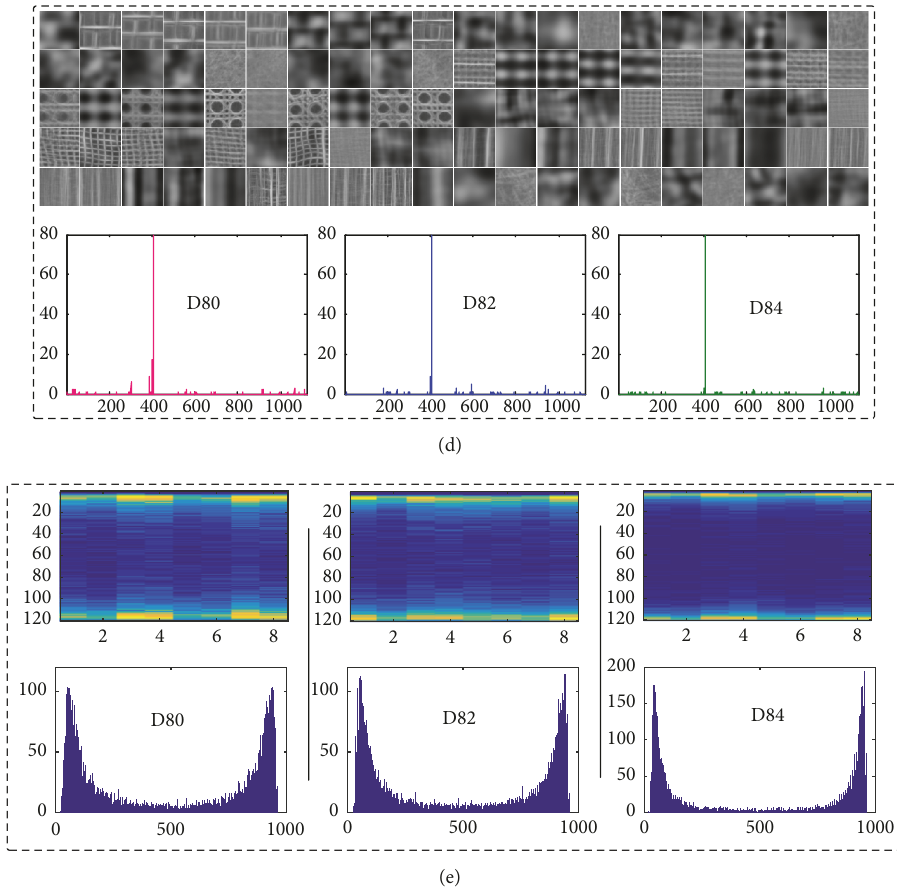
Figure 15: Feature extraction of TPs, D80, D82, and D84, based on GLCM, GWT, and VZ algorithm and WLD methods. (a) Original TPs, D80, D82, and D84, apparently with great visual similarity; (b) GLCM-based texture features; (c) GWT features, which tend to be the same trend in all the forty subbands; (d) histogram-based texture feature representationbased on VZ algorithm proposed by Varma and Zisserman [11], with the first 100 textons learned from the training image with MR8 filter banks class by class. PATCH and PATCH-MRF methods are their more recently texture classification methods, which has the similarity processing scheme but the original pixel patches are used and which can achieve the similar results for TP representation. (e) WLD histogram of D80, D82, and